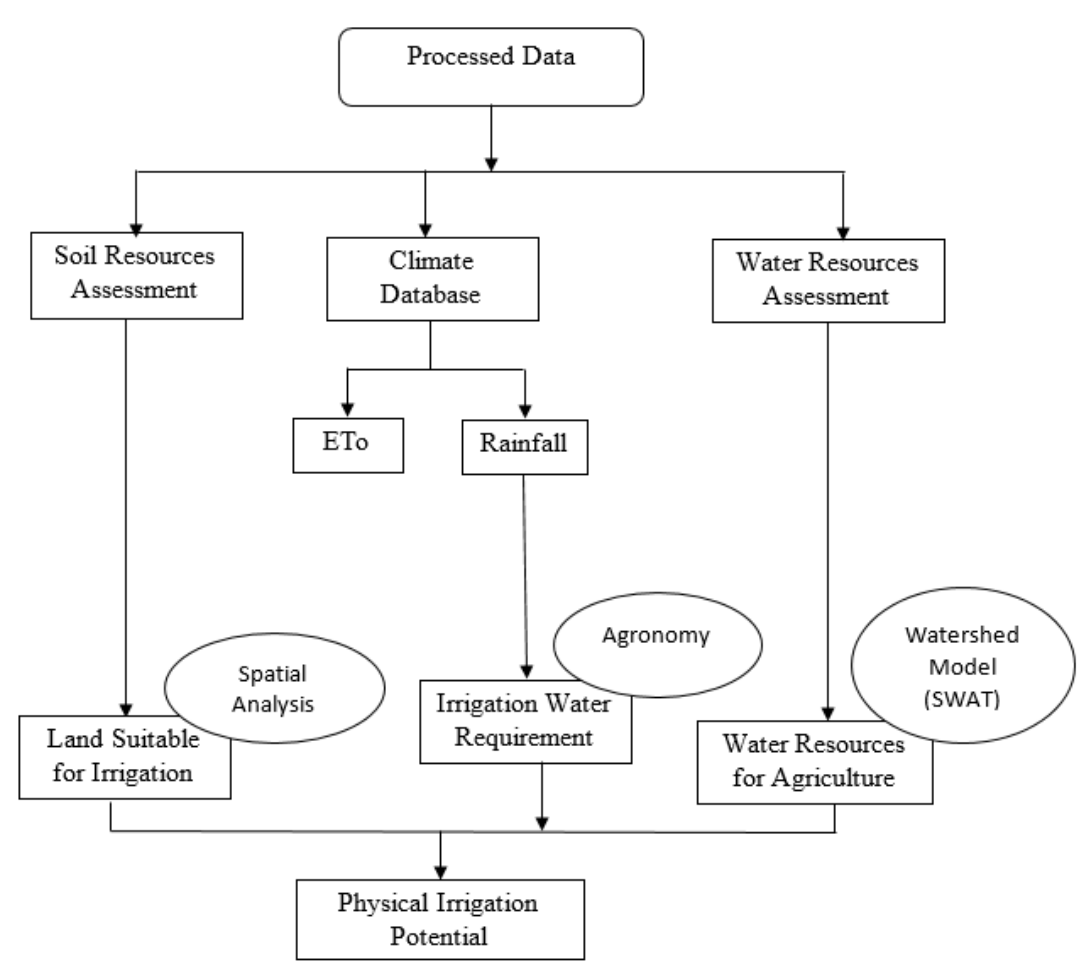
Figure 6. The general flow chart for the assessment of irrigation potential. ETo: evapotranspiration.